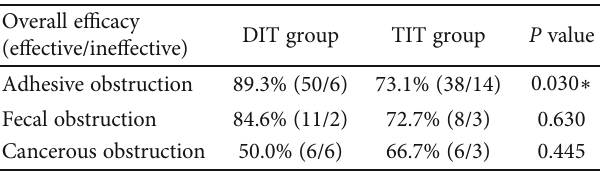
Table 3: Therapeutic e ffi cacies for di ff erent types of intestinal